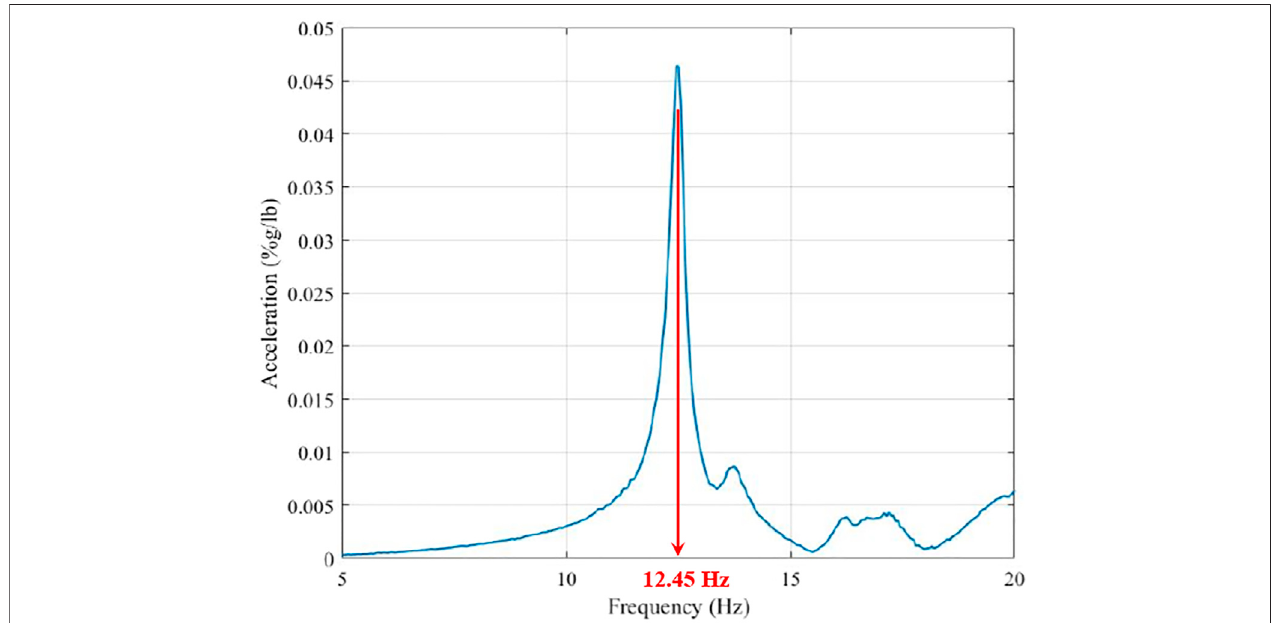
FIGURE 5 | Driving point FRF magnitude measured for the bare slab con fi guration (Location 12).